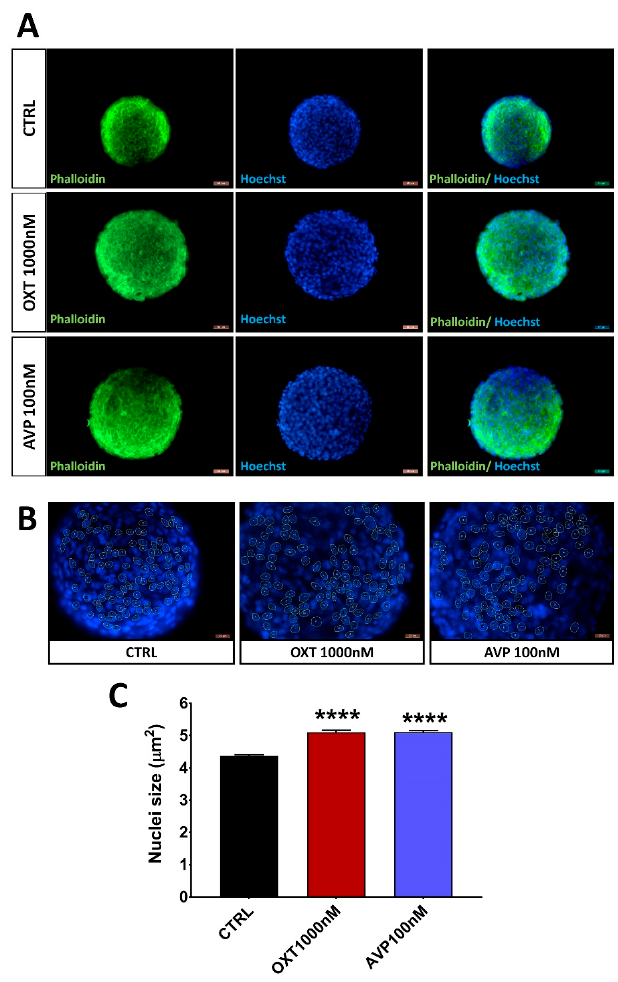
Figure 4. ( A ) Representative confocal images of 3-day-old H32 neurospheroids treated with either H 2 O (control), 1000 nM OXT, or 100 nM AVP for 3 days. Phalloidin is marked green and Hoechst 3334s is marked blue. ( B )Visualization of the quantification of nucleus size in a control, OXT, or AVP treated spheroid. Yellow circles indicate analyzed nuclei within that spheroid. Scale bars represent 50 µ M. ( C ) Quantification of nucleus size by Hoechst 33,342 staining and shape detection. Nucleus size increased from 4.3 to 5.064 and 5.100 µ m 2 (n = 100 F (2,296) = 83.26, p = 0.0001, Holm–Sidak **** p <